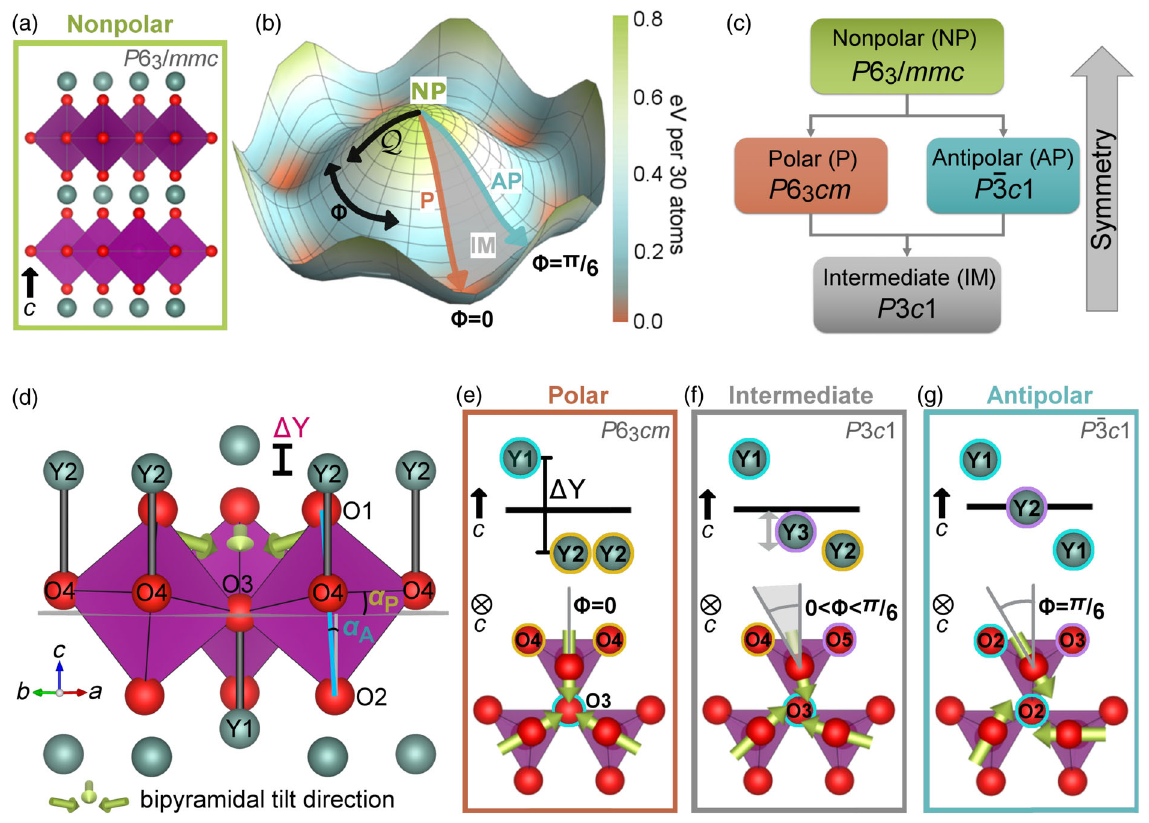
FIG. 1. Structures of YMnO 3 phases. (a) The high-symmetry nonpolar (NP) structure with purple MnO 5 bipyramids and turquoise Y cations. Oxygens are shown in red. (b) The Landau free energy of the hexagonal manganites as a function of the two-component order parameter ( Q , Φ ) resembling a Mexican hat, with the NP structure at the top. In the brim of the hat, the polar (P), antipolar (AP), and intermediate (IM) subgroup structures occur at the minima, maxima, and intermediate regions, respectively. (c) Group-subgroup relationship between the high-symmetry nonpolar structure and the subgroup structures found in the brim of the Mexican-hat energy landscape. (d) The order-parameter observables for the polar subgroup are the bipyramidal tilt amplitude (angles α and α ) and A P corrugation of Y cations ( Δ Y). Note that Δ Y denotes the distance in the c direction between Y1 and Y2. Green arrows indicate the directions of the bipyramidal tilts. The angle between the O1-O2 line and the c axis defines the apical tilt α and is a robust measure of A the order-parameter amplitude Q irrespective of the value of Φ . The plane through the three in-plane oxygens (one O3 and two O4) relative to the ab plane defines the planar tilt angle α and is related to both the order-parameter amplitude Q and angle Φ . (e) – (g), P Structures of the subgroups at different order-parameter angles Φ : Y off-centering pattern (top) and bipyramidal tilting directions, indicated by green arrows (bottom). Atomic sites for the three subgroups are labeled and coded with colored circles to emphasize which positions are symmetry related in each phase. Atom positions with the same color markings are aligned along the c axis and have the same multiplicity. A detailed overview of the atomic positions for the space groups is given in Fig. S1 of the Supplemental Material